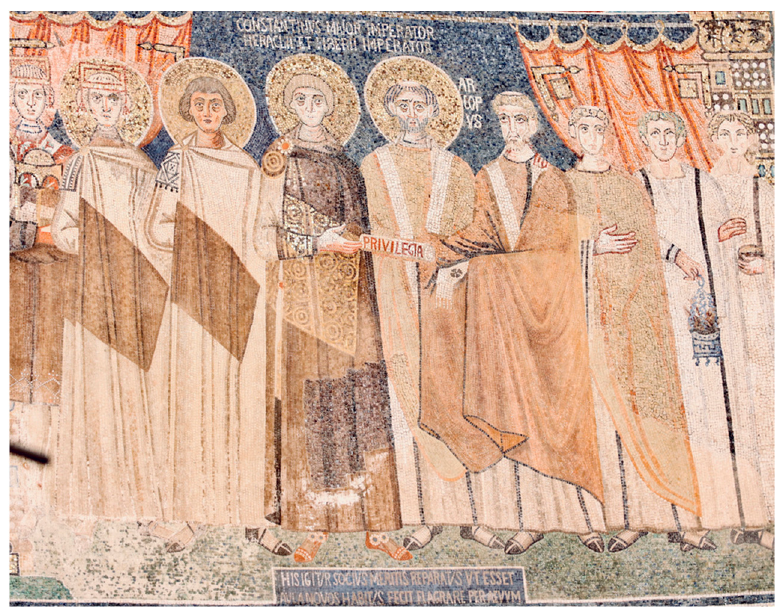
Figure 14. Mosaic panels with privileges, apse mosaics, Sant’Apollinare, Classe (photo: W. Bor- ghini).